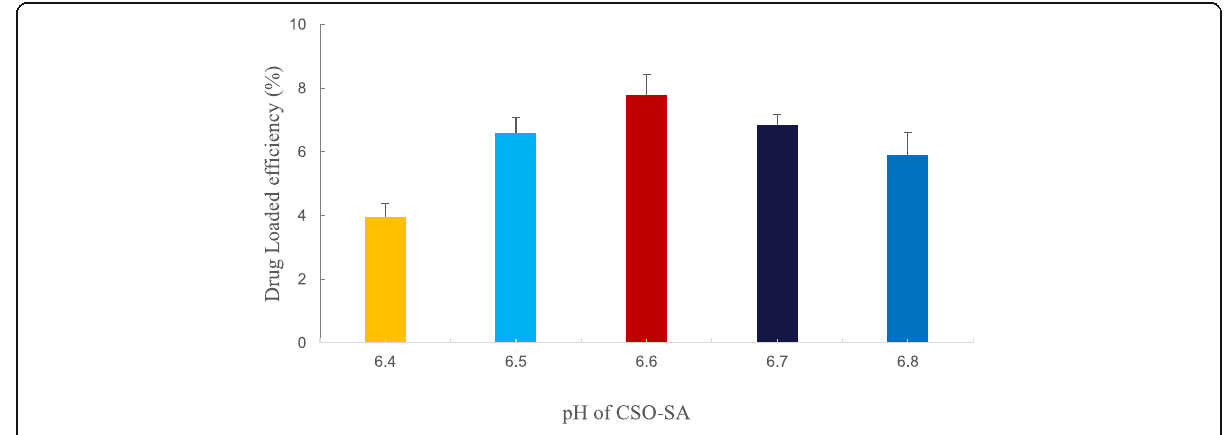
Fig. 4 Effects of different pH values of CSO-SA grafts on drug loading. Data are presented as means ± SD ( n =